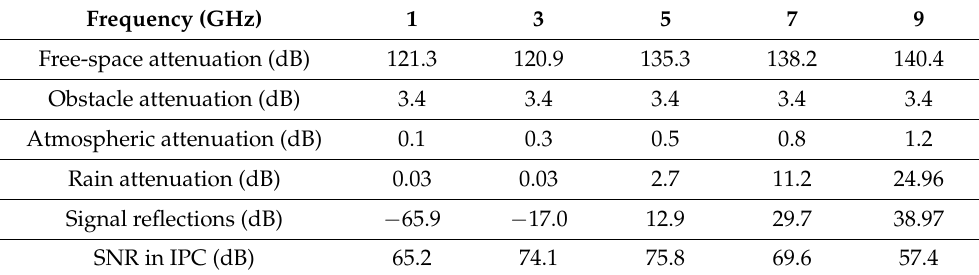
Table 3. Path attenuations for the simulated terrestrial system.